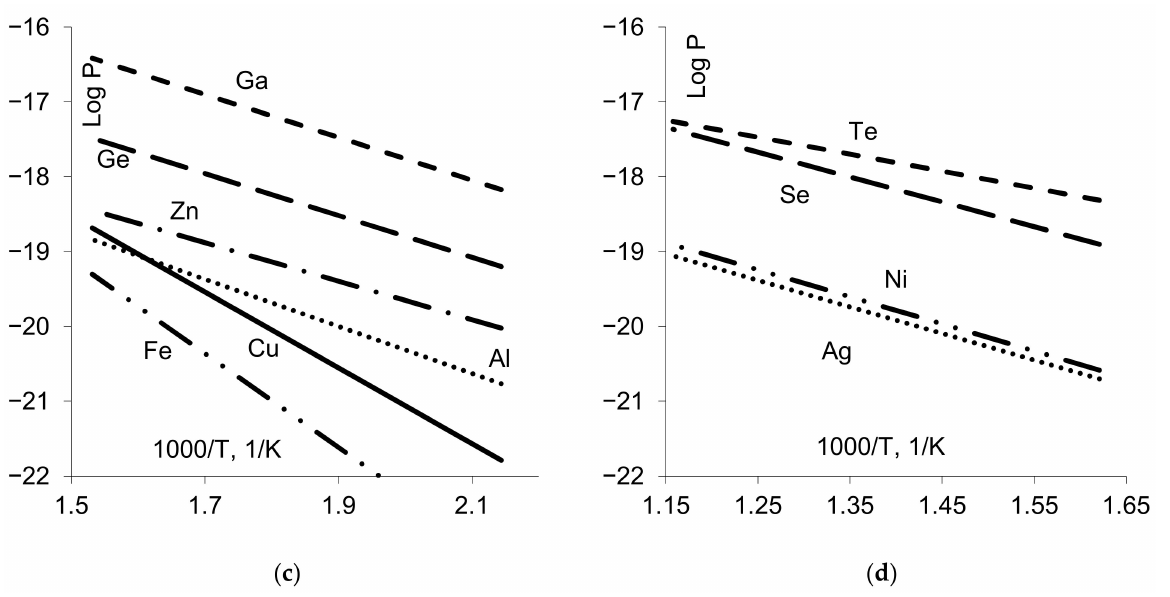
Figure 2. Compilation of the GB diffusion data in Cu ( a ), Ni ( b ), Al ( c ) and Ag ( d ) for “B”